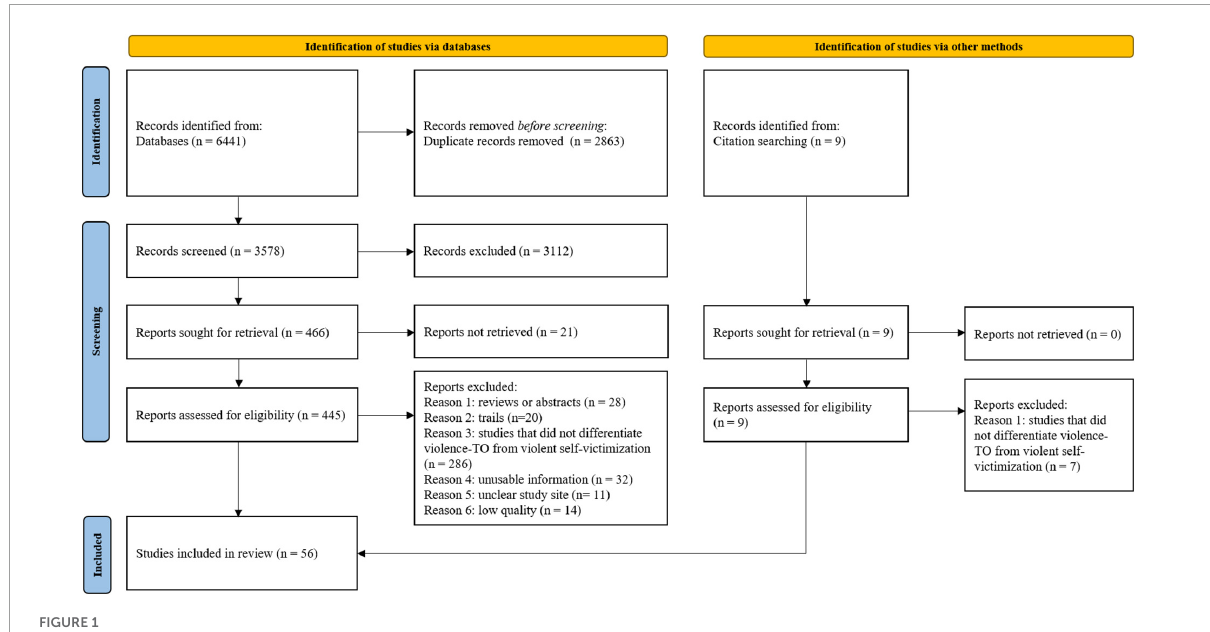
FIGURE1 Study selection.